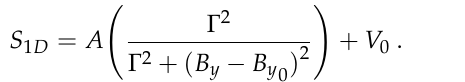
Figure 2. ( a ) (top), Hanle resonances, showing transmission, A , across the transverse axis as a function of longitudinal magnetic field; far detuned from zero-field (light line) to zero field, B z ( a ) (bottom), Hanle resonances, showing transmission, A , across the longitudinal axis as a function of the transverse magnetic field; far detuned from zero-field (light line) to zero field, B x line). ( b ), Hanle resonances across two axes. The transverse and longitudinal magnetic fields, B x & B z , are swept across the x - and z -axes to generate a 2D landscape of the Hanle resonance. Colour indicates the measured light transmission amplitude ( A ) on the photodetector, normalised with respect to the maximum (1) and minimum (0) transmission. ( c ), modulation of the magnetic field is applied across the y -axis as the transverse field, B y , is swept from B y demodulated and the demodulated amplitude with respect to ( B y ) is shown by the black solid line, the linear sensing region is shown by the red dashed